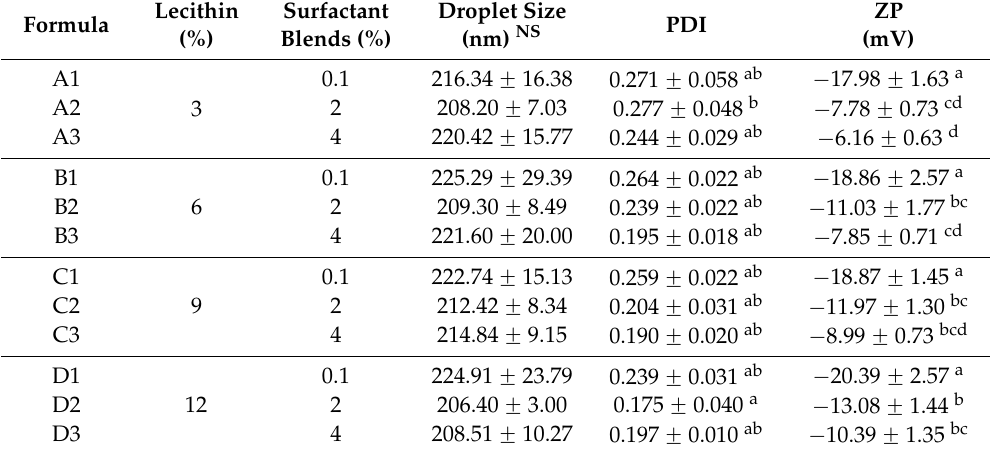
Table 1. Emulsion droplet size, polydispersity index (PDI) and zeta potential (ZP) of SEOF.